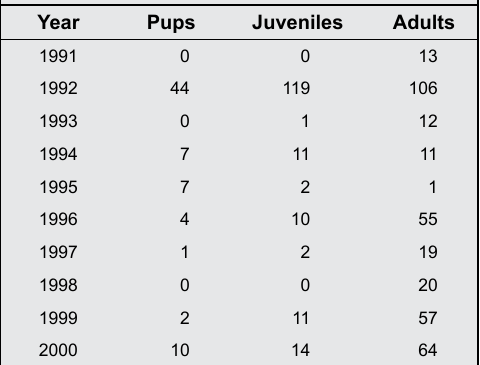
Table 1 . Grey seal removals from the Gulf of St. Lawrence from scientific collections. Juveniles are 1 to 3 years old, and adults are 4 years old and